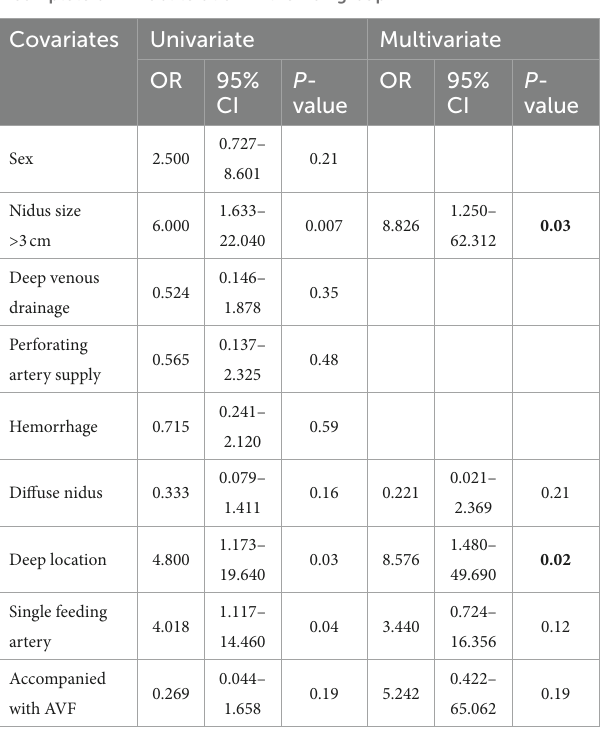
TABLE 2 Characteristics and outcomes of the embolization procedure. TABLE 3 Univariate and multivariate analyses for predictors of incomplete bAVM obliteration in the PCT